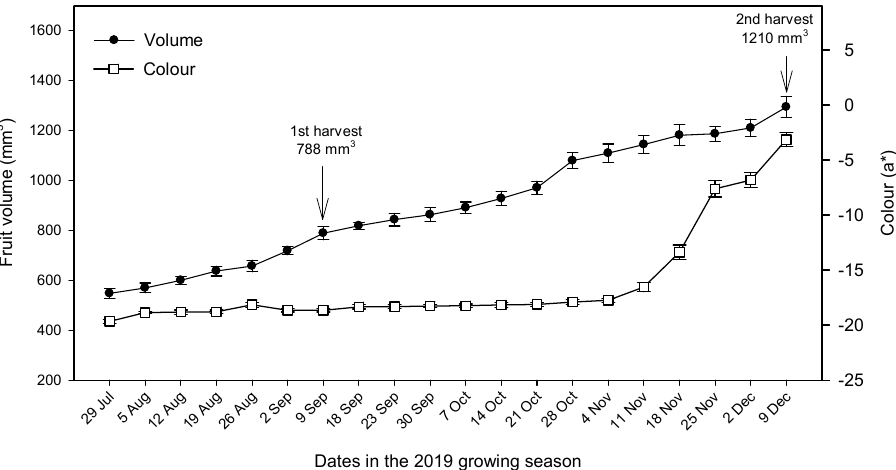
Figure 4. Evolution of fruit volume and colour represented at the left and right axes, respectively, in lemon fruits during development and on-tree ripening in the 2019 growing season.